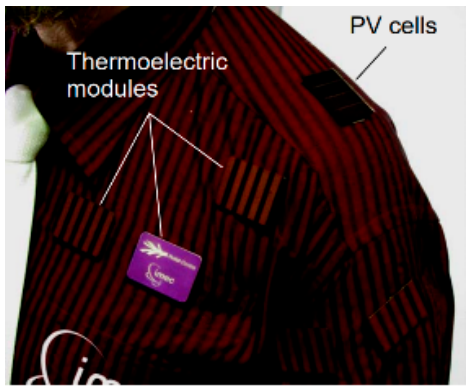
Figure 10. Wearable Thermoelectric Generator (WTEG) integrated into a shirt [132].